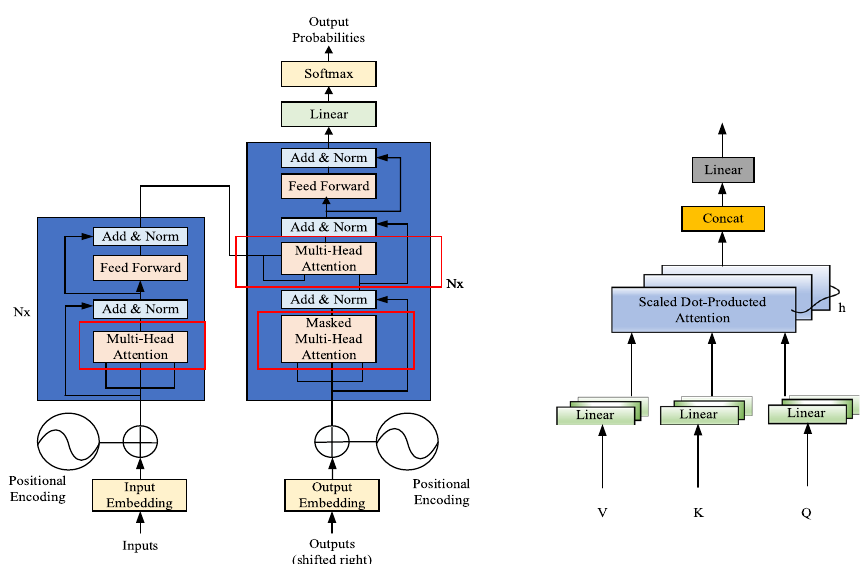
Fig. 6 Transformers architecture to efficiently model